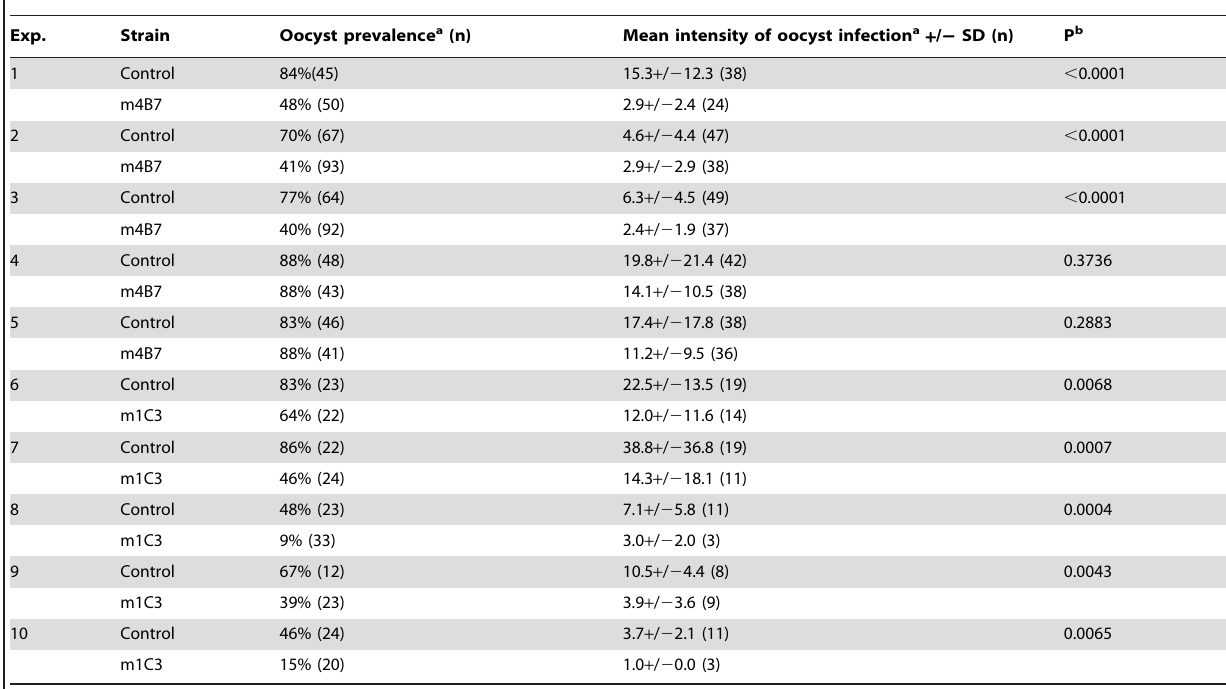
Table 1. Oocyst prevalence and mean intensity of infection in P. falciparum -infected mosquitoes.